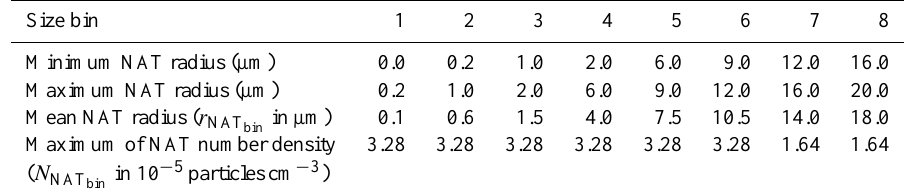
Table 1. The eight size bins in submodel PSC used for the kinetic growth NAT parameterisation. Size